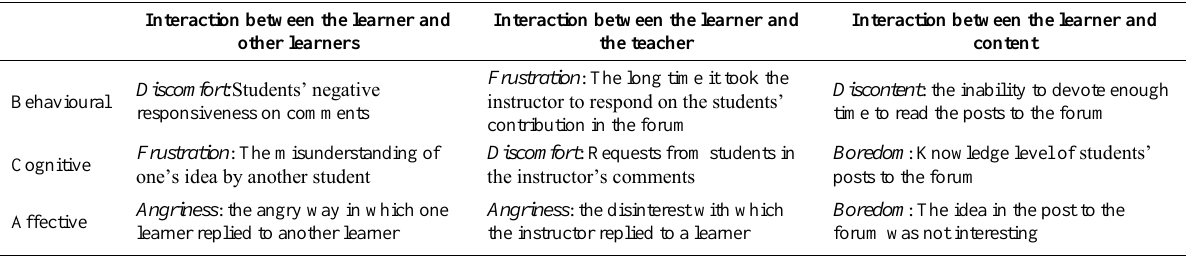
Table 10. Occurrences in forums that resulted in a negative affective engagement.